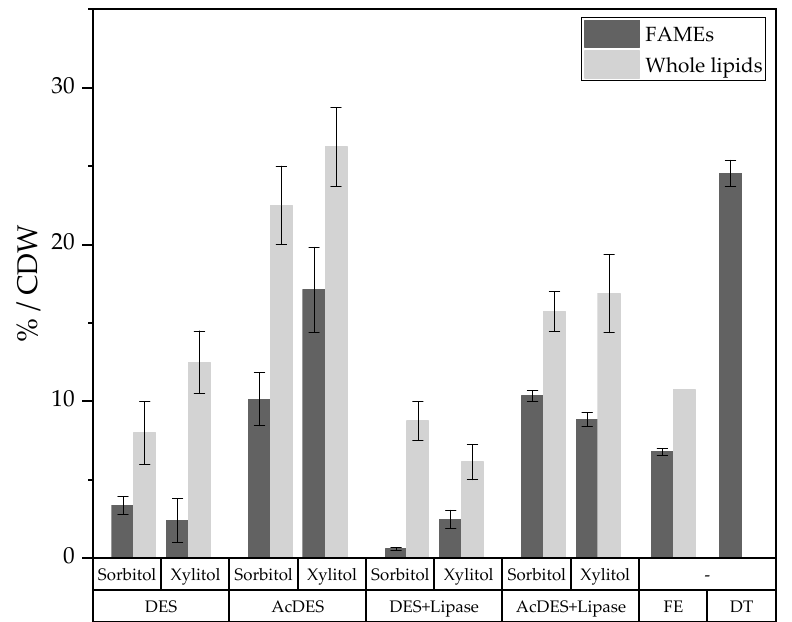
Figure 4. Fatty Acid Methyl Esters per Cell Dry Weight (FAMES/CDW) [%] for the microwave extraction of fatty acids under different reaction conditions, the Folch extraction process (FE), and the direct transesterification of the oily biomass to FAMEs (DT). Mean standard deviation indicates significant differences ( p < 0.05).